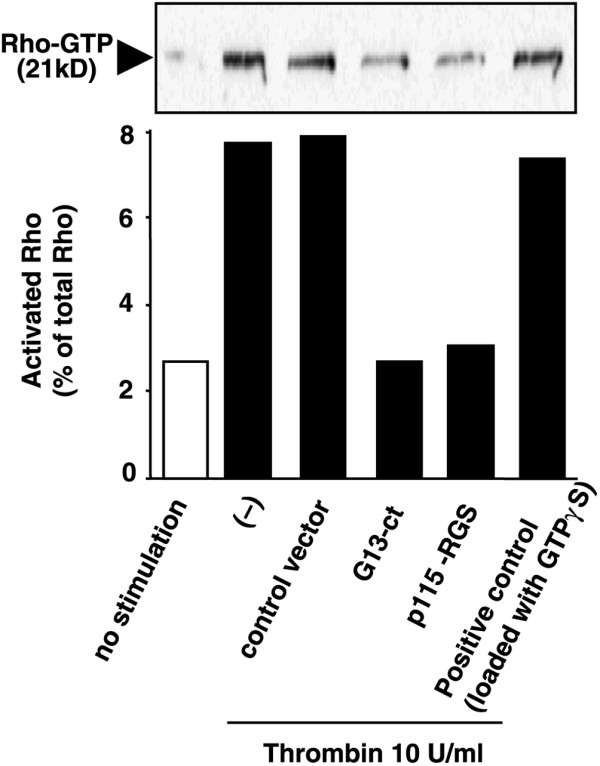
Inhibition of thrombin-induced Rho activation by expression of Gα13-ct and p115RGS in RA synovial fibroblasts. Rheumatoid arthritis (RA) synovial fibroblasts (SFs) were or were not infected with adenoviruses encoding green-fluorescent protein (GFP) (control vector), the C-terminal regions of Gα13 (Gα13-ct), or P115RGS. Cells that were not infected with adenovirus were incubated in the medium alone. Cells were then cultured for 48 hours in DMEM containing 1% FCS, then stimulated with 10 units/ml thrombin for 1 minute or were loaded with GTPγS (positive control), after which they were lysed to measure Rho activity. Rho activity is indicated by the amount of Rho bound by the Rhotekin-Rho-binding domain (RBD) (top). The percentage of activated Rho (graph) is expressed as a ratio relative to 4% of total Rho (4% of total protein used in the RBD bead pull-down experiments). Results are representative of three experiments. Western blot analysis confirmed that equal amounts of total Rho were used for the pull-down assay under each condition (data not shown). (-), cells without infection; p115RGS, regulator of G-protein signaling domain of p115Rho guanine nucleotide exchange factor.